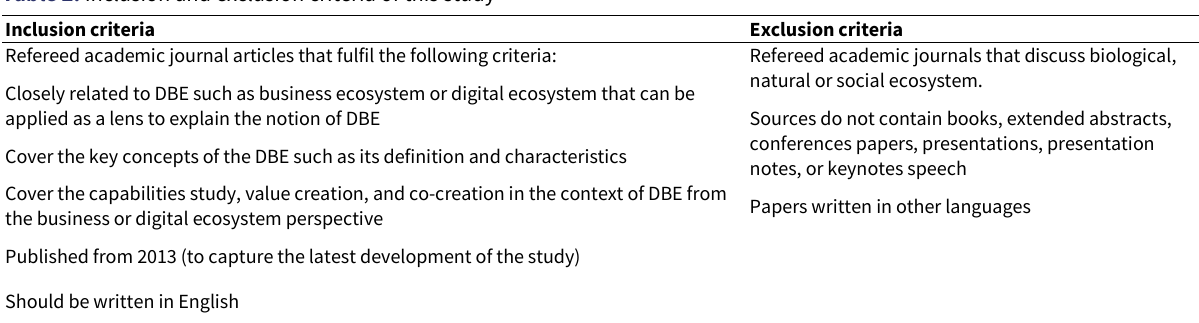
Table 2. Inclusion and exclusion criteria of this study Inclusion